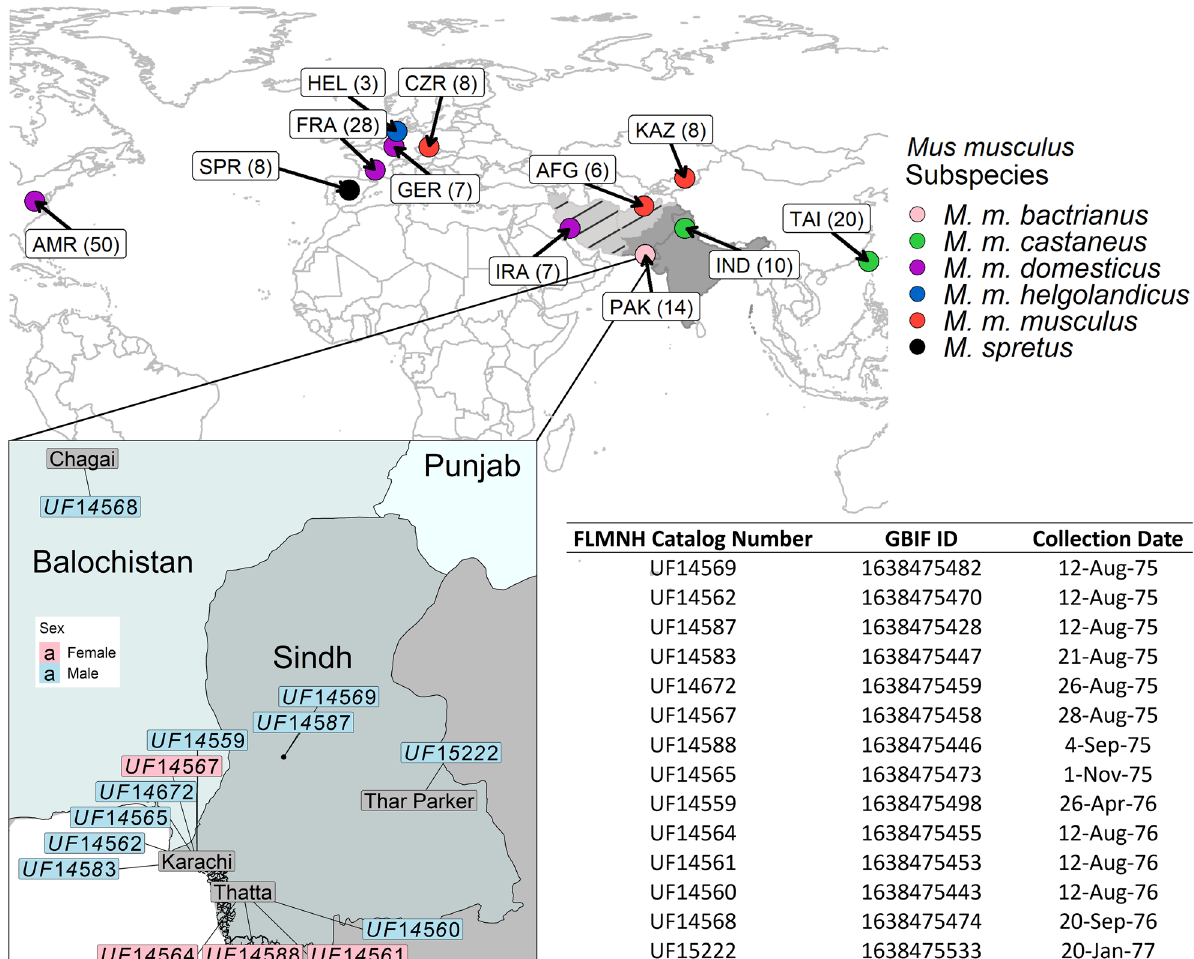
Figure 1. Map showing the approximate geographic sampling locations of house mouse populations profiled by whole-genome sequencing. The house mouse ancestral region extends from India “IND” and Pakistan “PAK” (dark grey area) and may include the broader region from Iran “IRA” and Afghanistan “AFG” (light grey area with black markings). All genome sequences except for PAK were retrieved from public databases 33–35 . The additional sequences include populations from America (AMR), France (FRA), Germany (GER), Heligoland (HEL), Kazakhstan (KAZ), and Czech Republic (CZR), Taiwan (TAI), and M. spretus from Spain (SPR). Each population sample sizes are indicated in the bracket. The enlarged plot inset shows the locations of PAK samples collected across four counties in the Sindh region of Pakistan. Florida Museum of Natural History (FMNH) Catalog numbers, Global Biodiversity Information Facility (GBIF) identifiers 41 , and collection dates for each PAK sample are presented in the